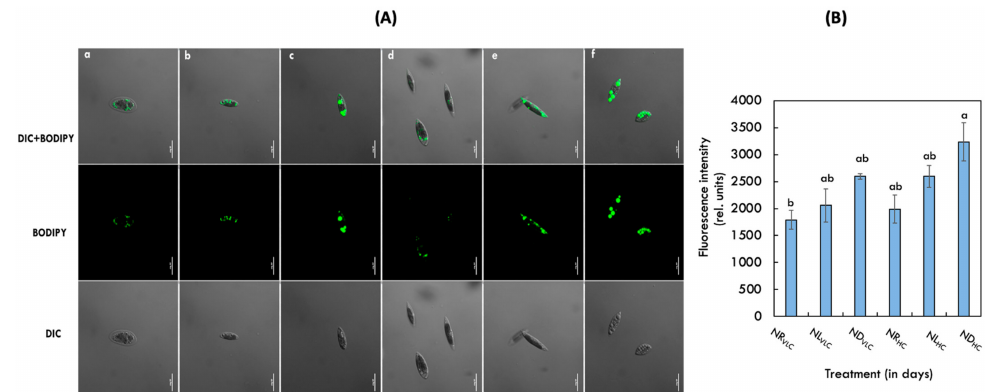
Figure 2. ( A ) BODIPY visualization of Monoraphidium cells on the 10th day of cultivation subjected to ( a ) NR VLC ; ( b ) NL VLC ; ( c ) ND VLC ; ( d ) NR HC ; ( e ) NL HC ; ( f ) ND HC conditions using confocal microscopy. ( B ) Relative fluorescence intensity of the stained cells on the 10th day of cultivation in the NR VLC , NL VLC , ND VLC , NR HC , NL HC , and ND HC conditions. Values indicated are mean average ( n = 3) ± S.E.; different lowercase letters indicate the statistical significance by two-way ANOVA with